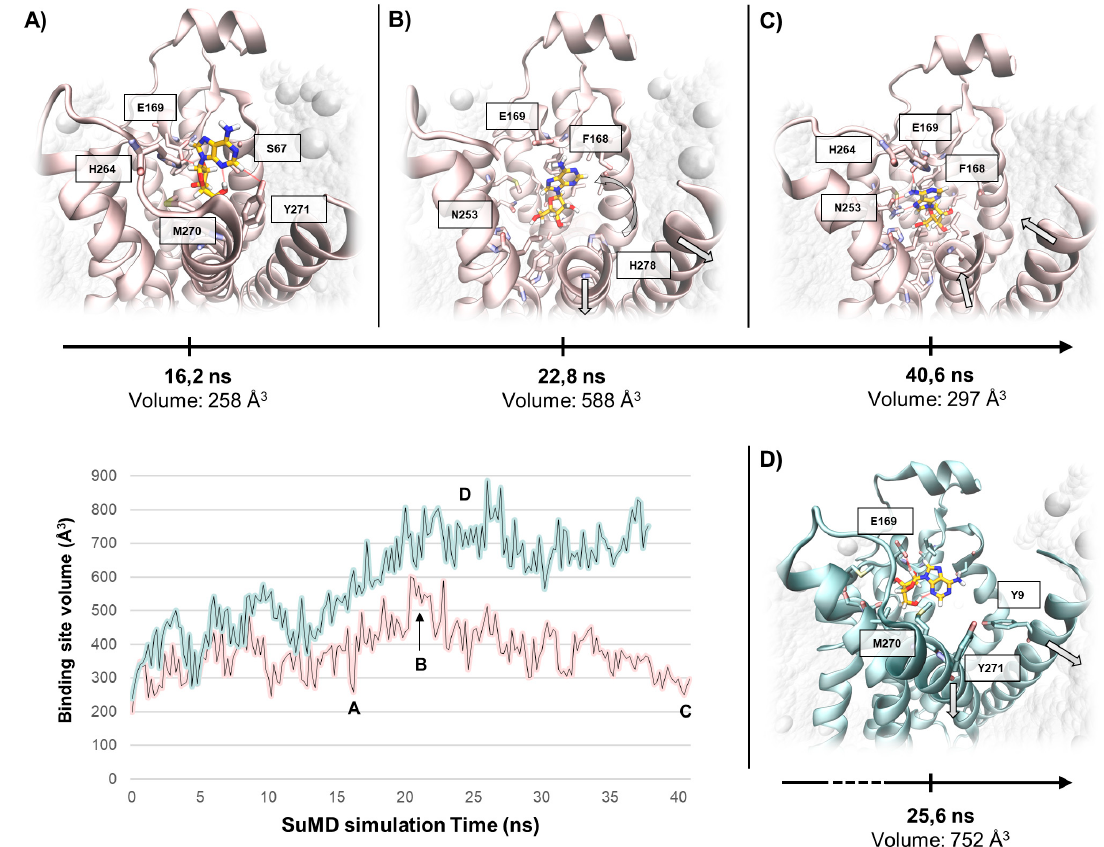
Figure 5. The orthosteric site volumes change differently during SuMD simulations of the intermediate-active and the inactive A 2A ARs. Panels A , B , and C depict three snapshots from SuMD Replicate 3a, related to the key steps of the adenosine recognition. Initially, the agonist approaches the A 2A AR extracellular vestibule (A) and through a polar interactions network mediated by ECL3, TM2, and TM7 (whose overall organization is not perturbed with respect to the crystal structure), inserts the purine ring into the binding site (B). The adenosine is then able to reach the canonical binding mode (C) only when the cavity volume recedes toward the original value. On the A 2A AR inactive state, the binding site volume progressively increases due to the TM1 and TM7 outward movements (Panel D ), making the agonist binding more difficult.